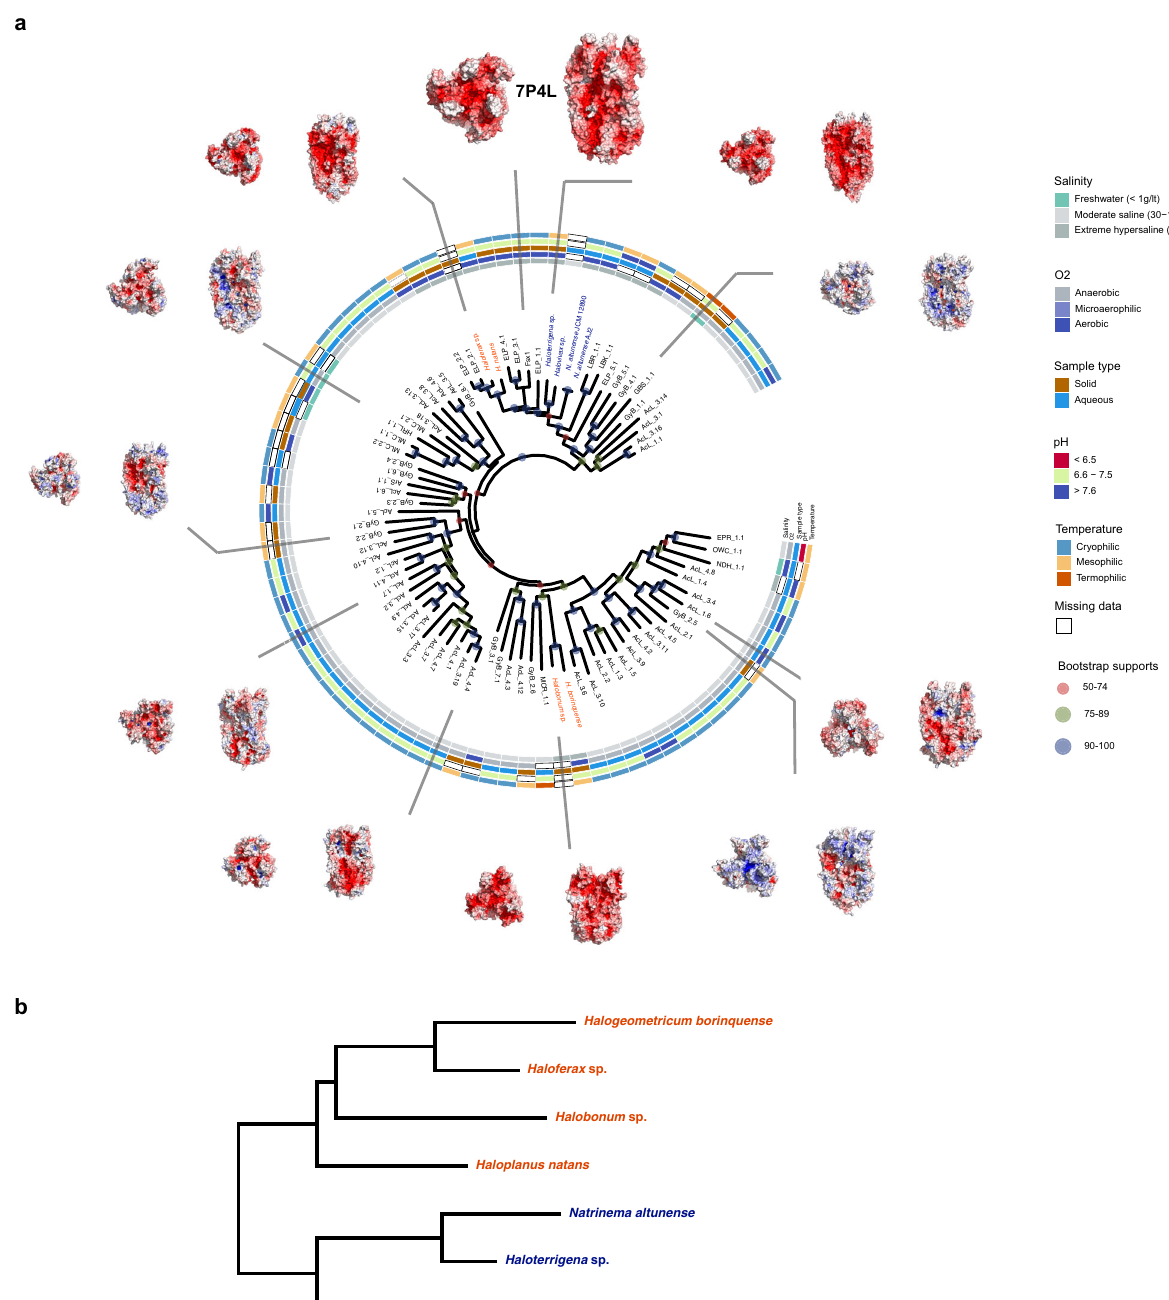
Fig. 6 Environmental distribution of Fsx1s. a Archaeal fusexins unrooted phylogeny, environmental details, and trimeric models 66 based on the Fsx1 X-ray structure (PDB 7P4L [https://www.rcsb.org/structure/7P4L], enlarged). Tree tip IDs coming from metagenomic data coded by sampling site, sample id and sequence (see Supplementary Data 1). Fsx1s from cultivated genomes are shown as Natrialbales and Haloferacales orders in blue and red, respectively. Surfaces colored and oriented as in Fig. 3a. Found in diverse environments and often differing in global surface properties, modeled trimers share hydrophobic tips. b Panel with phylogenomic tree for fsx1 -containing cultured archaeal species, showing incongruences between Fsx1s in